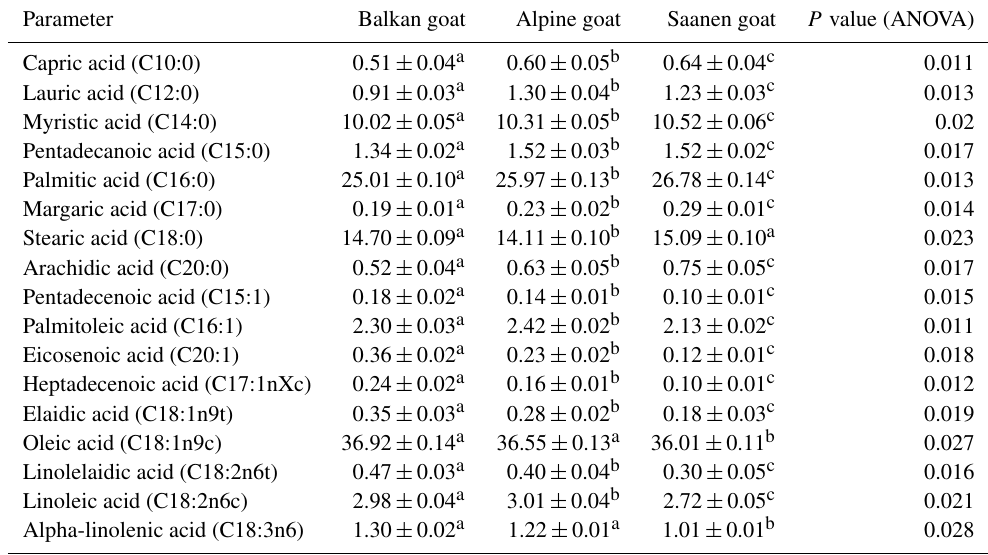
Table 2. Fatty acid composition of fresh goat meat (% of total fatty acids) ( m. gluteus superficialis ) ( n = 40 per breed). Parameter Balkan goat Alpine goat Saanen goat P value (ANOVA) Capric acid